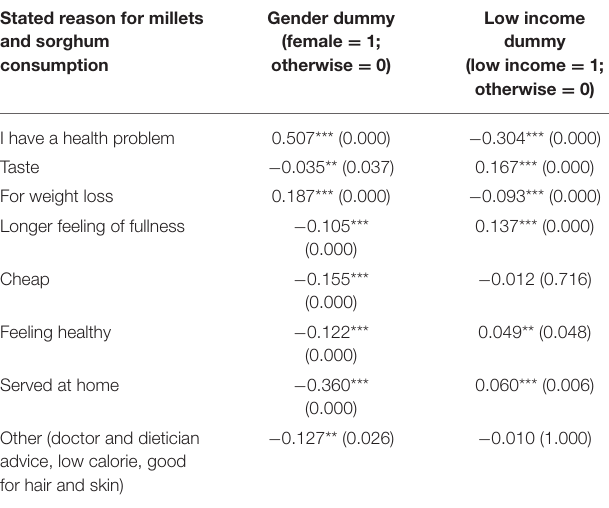
TABLE 4 | Relationship between reasons for consuming millets and sorghum and the demographic profile of the respondents: tetrachoric correlation coefficients and p -values ( n = 15,513).